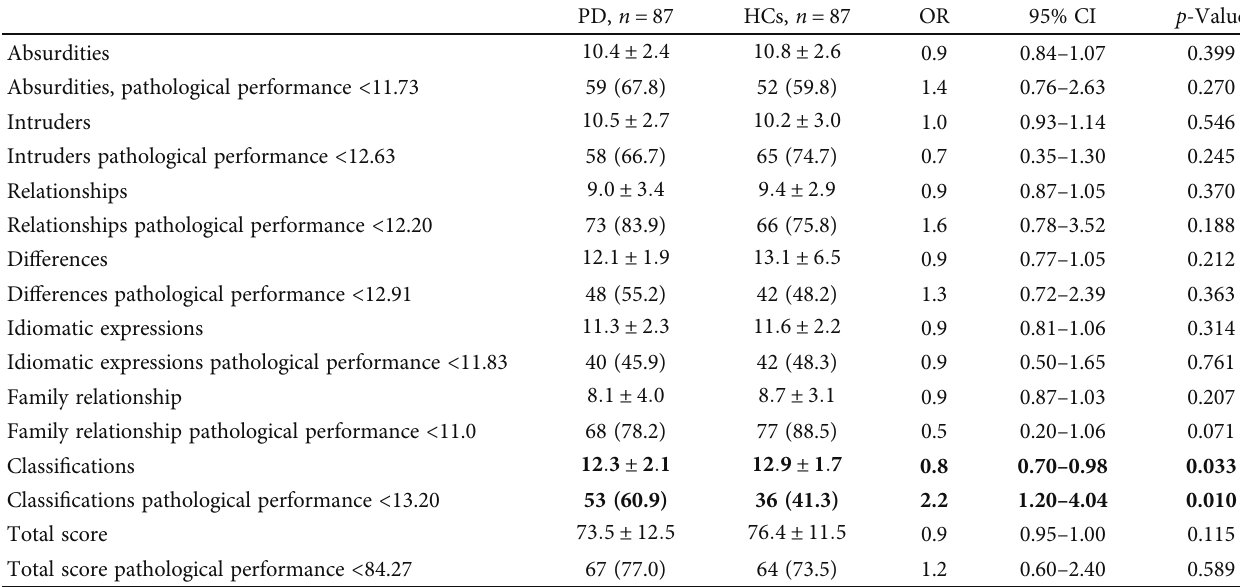
Table 2: Verbal reasoning in PD and HCs. Univariate